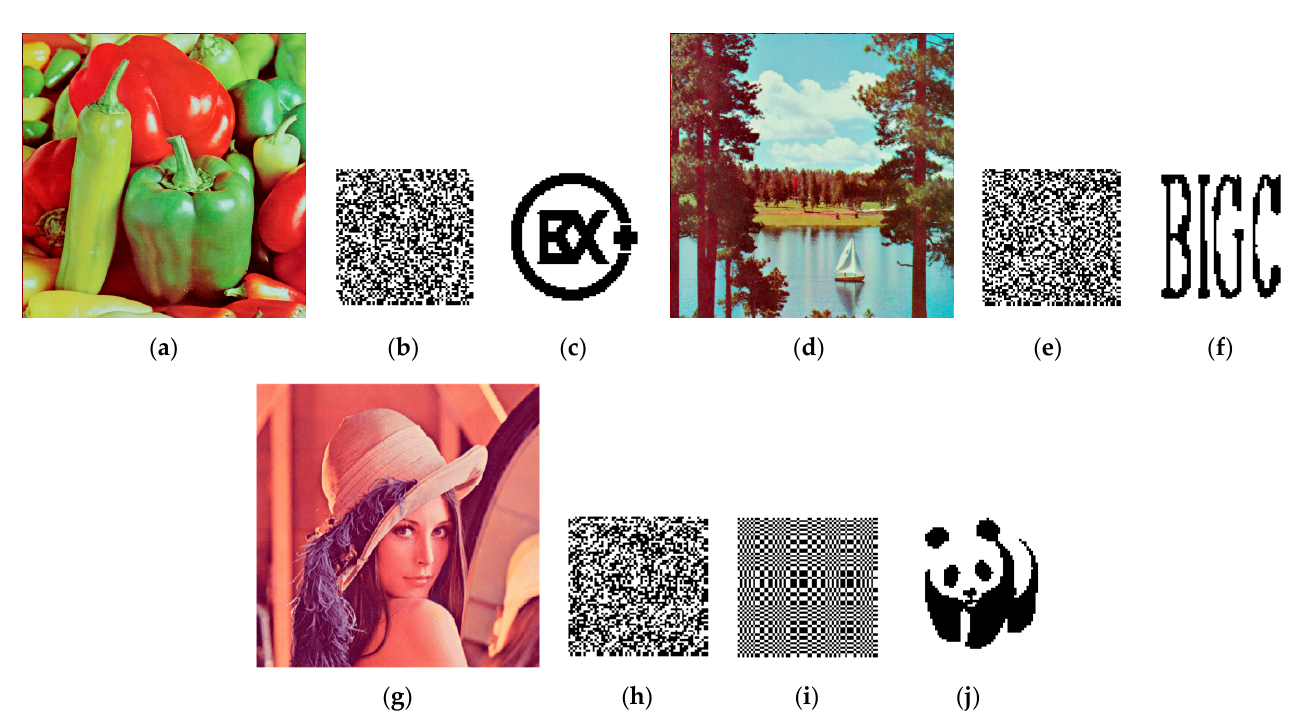
Figure 10. Simulation results of extracting robust watermark ( a ) and ( d ) are the watermarked images known to the attacker; ( b ) the ciphertext robust watermark extracted from; ( c ) the plaintext robust watermark of ( b ); ( e ) the ciphertext robust watermark extracted from ( d ); ( f ) the plaintext robust watermark extracted from ( e ); ( g ) the double watermark image to be attacked; ( h ) the extracted ciphertext robust watermark; ( i ) the equivalent XOR key matrix image obtained from the known plaintext attack; ( j ) the plaintext robust watermark obtained by the attacker.